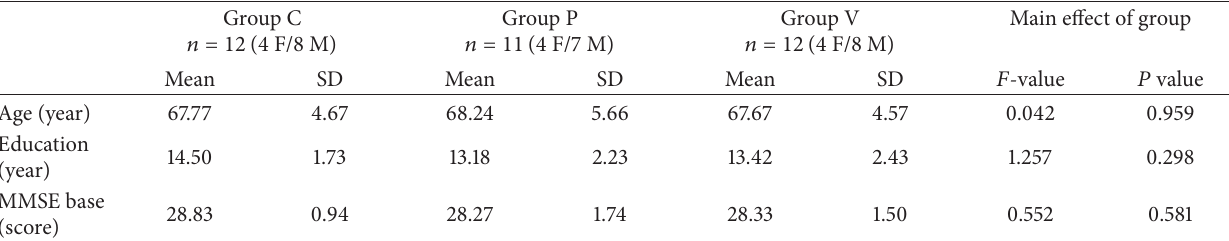
Table 1: Baseline characteristics of the